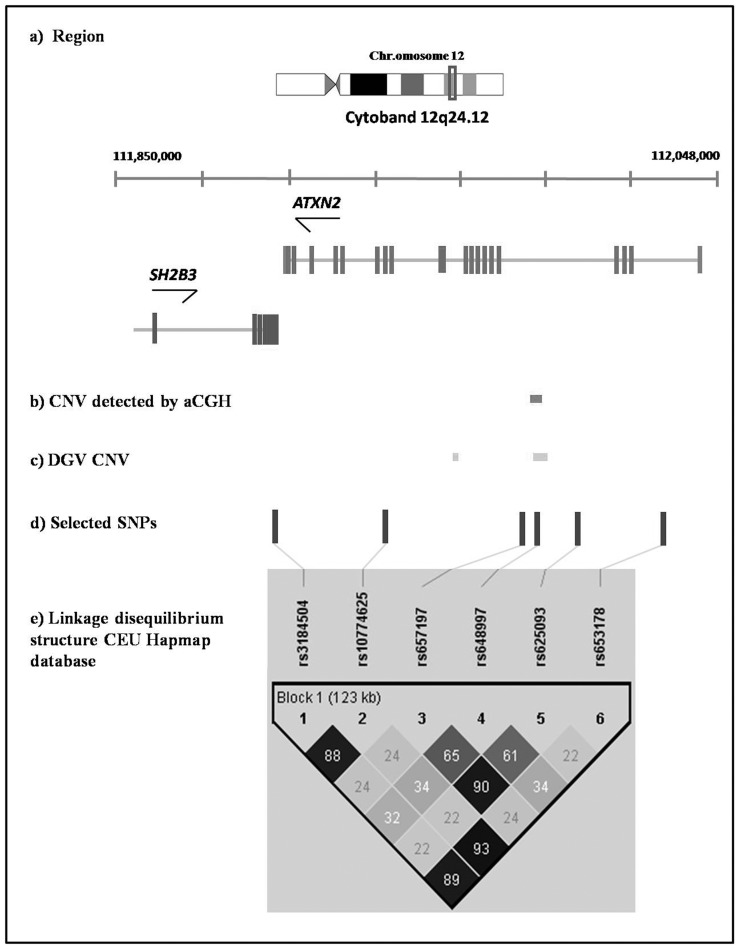
Candidate susceptibility region 12q24.12 identified by the combination of results obtained with array-CGH and published genome-wide association studies (GWAS) in related diseases.a) description of the region, b) location of the MCR identified in our array-CGH analysis, c) previously described CNVs in the region, d) SNPs selected for our genotyping analysis, e) linkage disequilibrium (LD) structure across the 12q24.12 locus. The LD structure has been obtained with Haploview software v.4.3, based on r2 coefficient calculated with the CEU HapMap database.